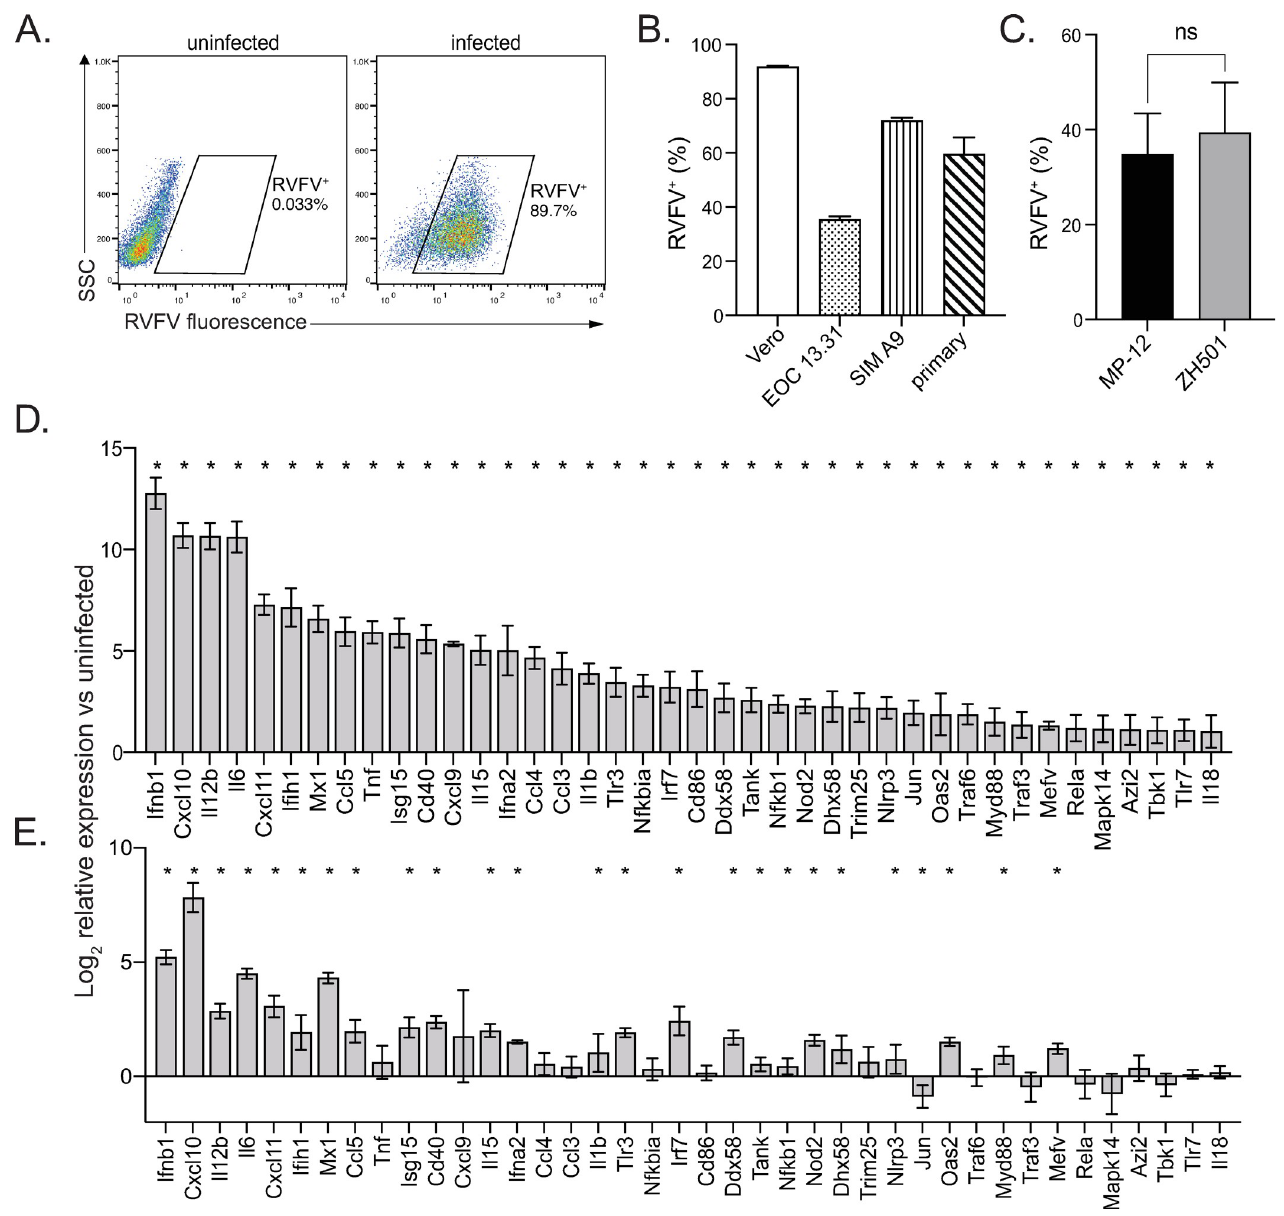
Fig 1. RVFV infects microglia. Microglia cell lines EOC 13.31 and SIM A9 and primary microglia derived from the brains of neonatal mice, along with Vero positive control cells, were infected with RVFV MP-12. The percentage of cells positive for RVFV was assessed by flow cytometry. Representative plots of Vero cell infection analysis (A). RVFV infection rate for all cell types (B). Primary microglia derived from wildtype (WT) mice were infected with RVFV MP-12 or ZH501 and the percentage of cells positive for RVFV was assessed by flow cytometry (C). The relative expression of 40 antiviral response genes with the highest fold change in infected versus uninfected cells (D). Data in (B-C) are shown as the mean +/- SD. Data in (D) and (E) are shown as the mean log 2 fold change in infected versus uninfected cells +/- SEM. � denotes significant changes in gene expression beyond 95% CI between uninfected vs infected cells.